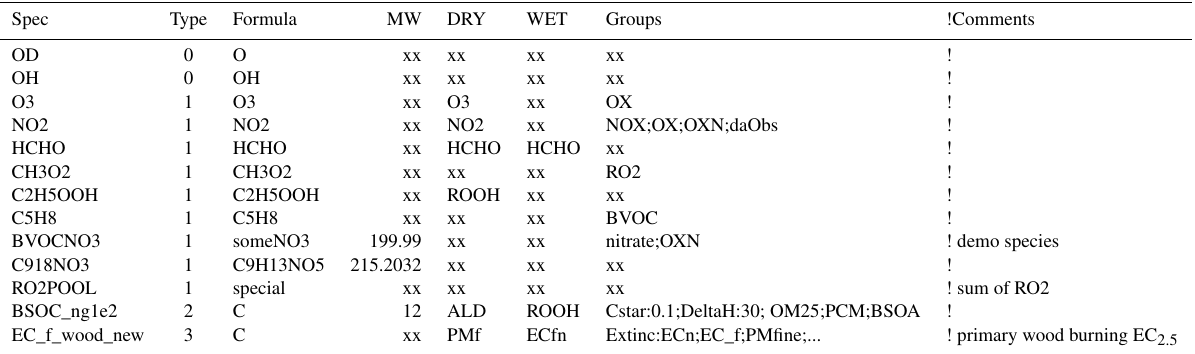
Table 6. Example content lines from GenIn_Species.csv input